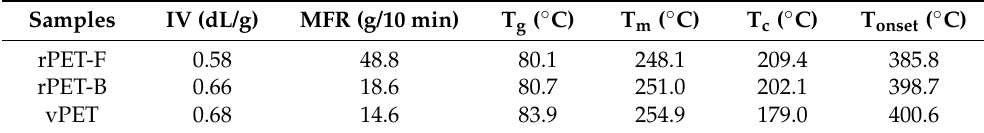
Table 1. The IV, the MFR and thermal properties of PET